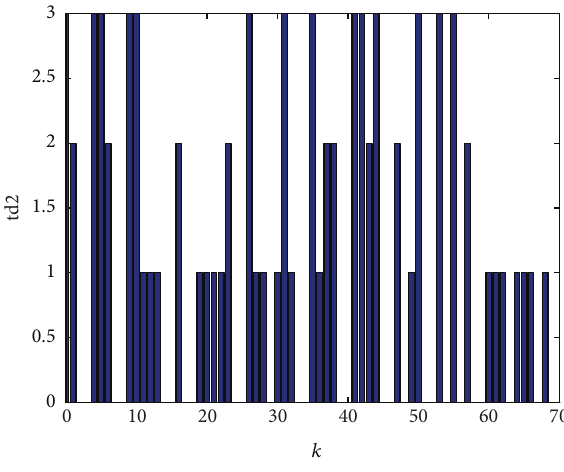
Figure 10: Bounded arbitrary time delays (Example 1).